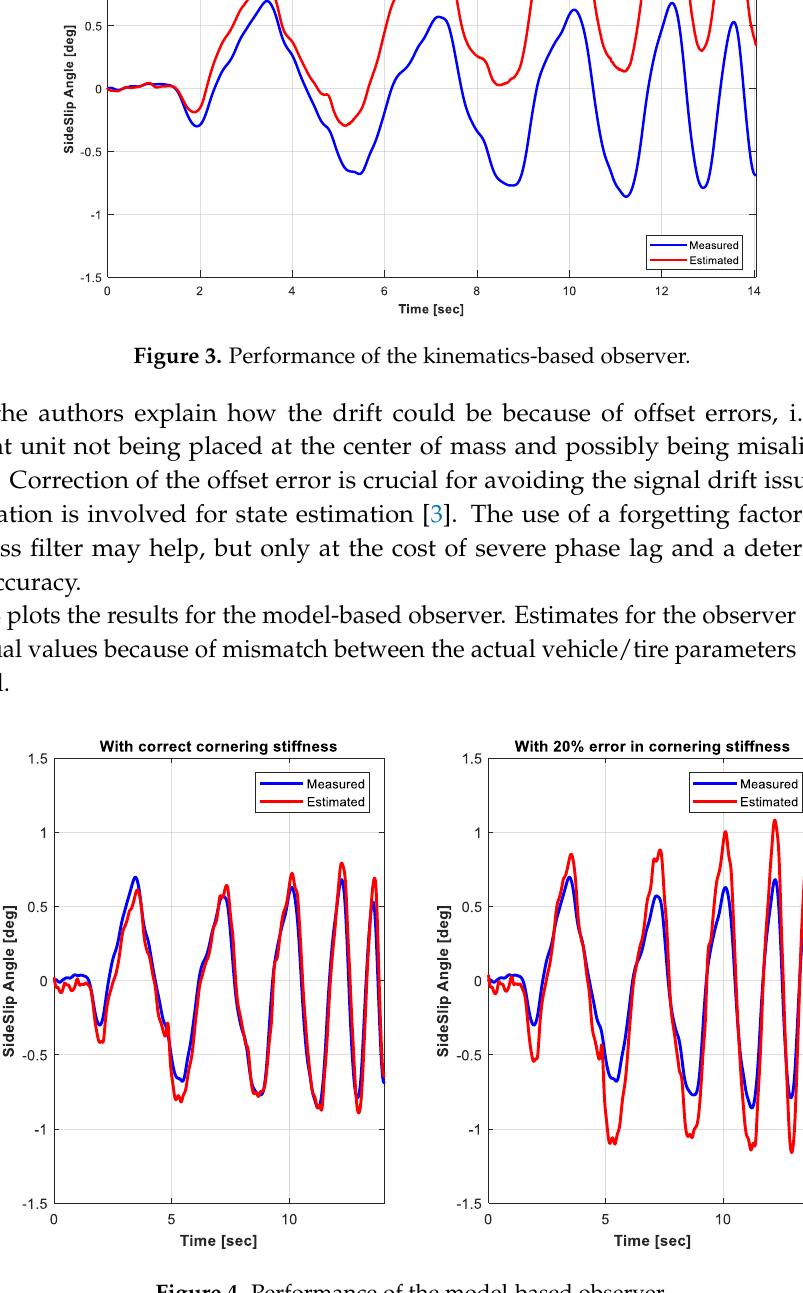
Figure 4. Performance of the model-based observer.